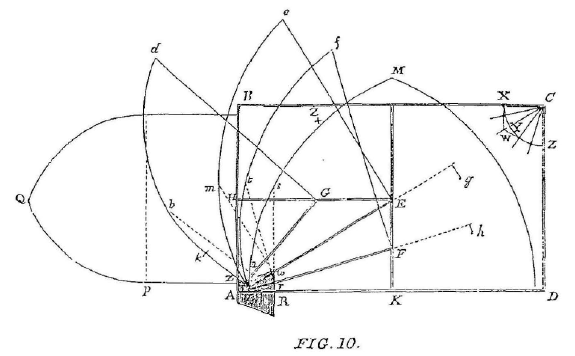
Figure 2 . One of the plates by Ribes for representation of the